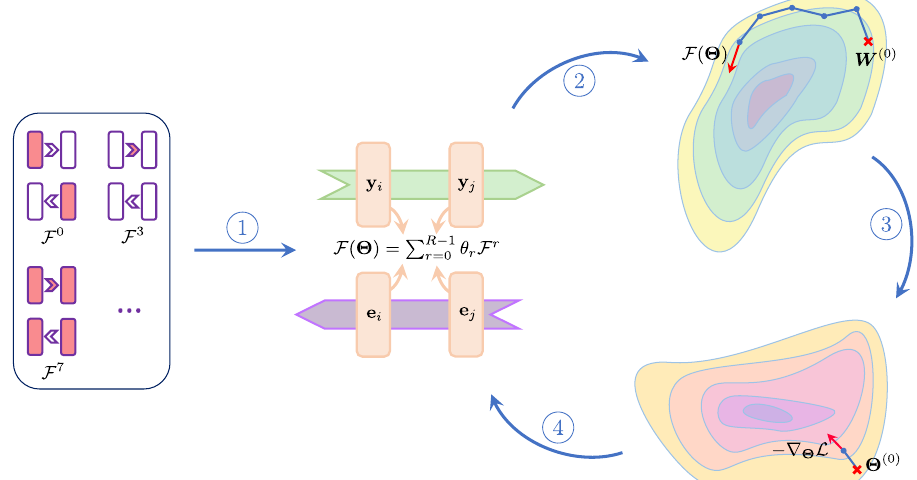
Fig. 2 | Schematic depiction of the meta-learning work fl ow. (1) A pool of R biologically plausible plasticity terms f F r g 0 ≤ r ≤ R (cid:1) 1 is exploited to de fi ne a plasticity rule F ð Θ Þ thatgovernstheweightupdatesof themodel f W .Eachterm F r integrates local elements available to the weight, including pre-synaptic activation y i , post- synaptic activation y j , pre-synaptic error e i , post-synaptic error e j , and the current state of the weight W i , j . Such terms are consistent with localplasticity if y i and e i are encodedbythesameneuron(seeDiscussion).Thelinearcombinationoftheseterms de fi nes plasticity rule F ð Θ Þ , where Θ ={ θ r ∣ 0 ≤ r ≤ R − 1} is the set of meta-parameters sharedacrossthenetwork.(2)Theparameterizedlocallearningrule F ð Θ Þ isusedto navigate the weight parameter space. At each episode ε , F ð Θ ð ε Þ Þ iteratively searches